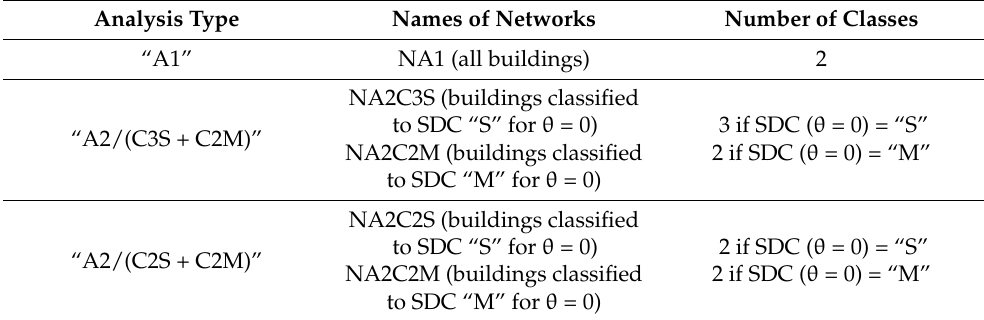
Table 3. Main characteristics of the types of analyses and the corresponding names of